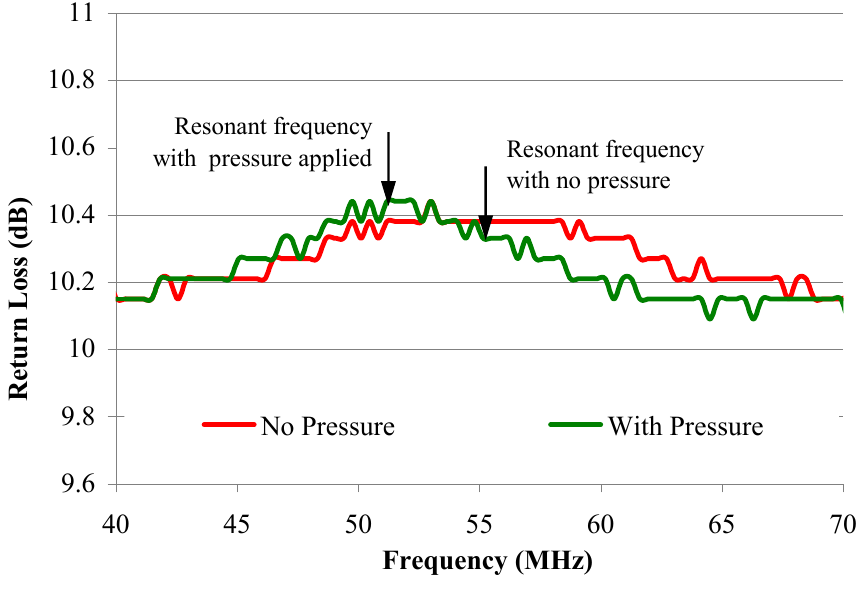
Figure 16. Change in resonant frequency of a sensor due to changes in pressure as measured through the pipe wall.